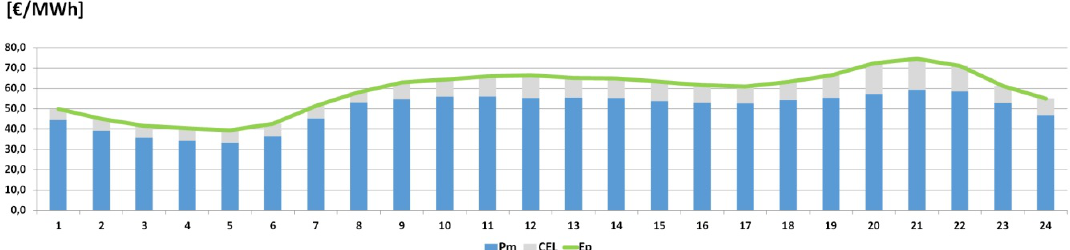
Figure 10. Equivalent energy price of the consumer for a typical day of September.